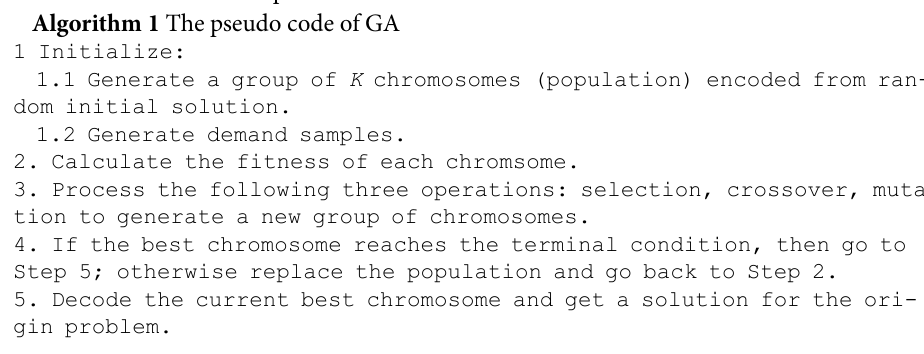
Algorithm 1 The pseudo code of